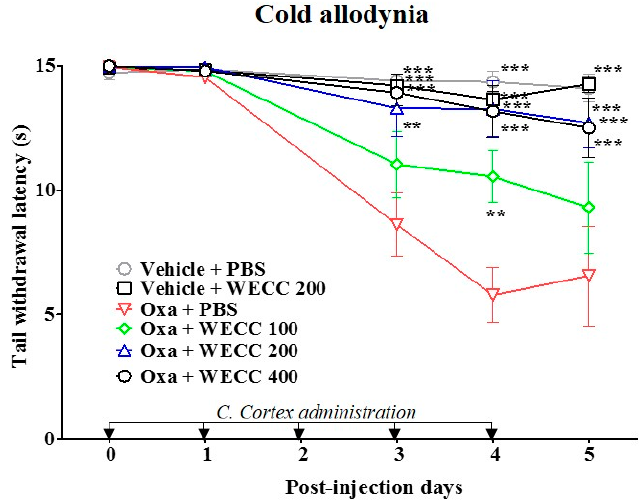
Figure 1. Effect of WECC in relieving oxaliplatin-induced cold allodynia in rats. Animals were randomly divided into five groups ( n = 6 per group). Oxaliplatin (Oxa) or 5% glucose (Vehicle) was administered intraperitoneally at day 0. WECC (100, 200, and 400 mg/kg) or PBS was administered orally for five consecutive days after injection of oxaliplatin or vehicle control. Data are presented as mean ± S.E.M.; ** p < 0.01, *** p < 0.001 vs. Oxa + PBS by two-way ANOVA followed by Bonferroni’s post-test.